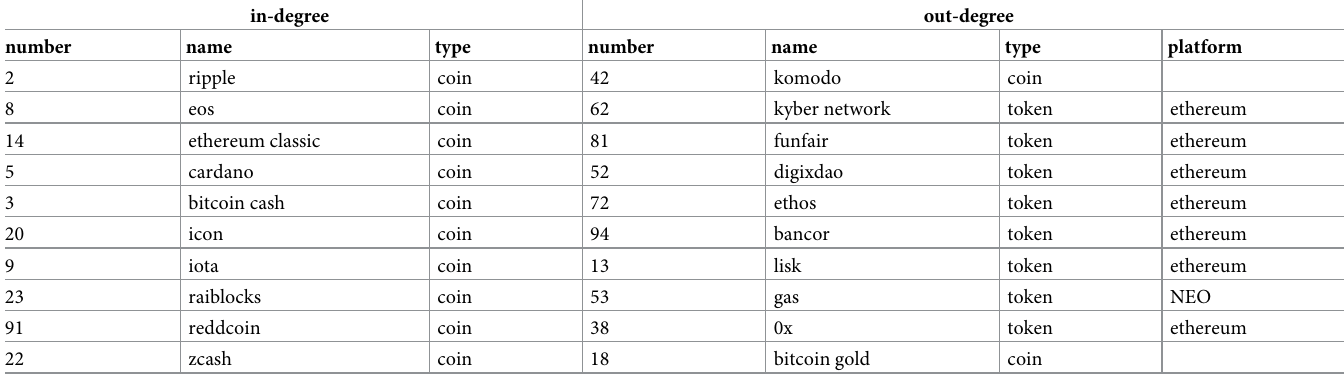
Table 4. In-degree and out-degree